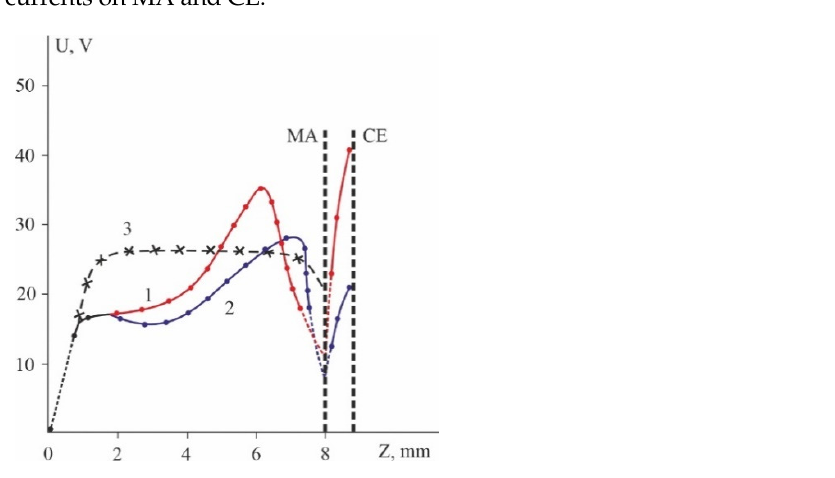
Figure 3. Potential distribution over the gap of the experimental device at different helium pressure values P He , Torr: 1–3; 2–6; 3–2; currents to the MA, A: 1–0.6; 2–0.4; 3–0.2; currents at the CE, A: 1–0.04; 2–0.02; 3–0.